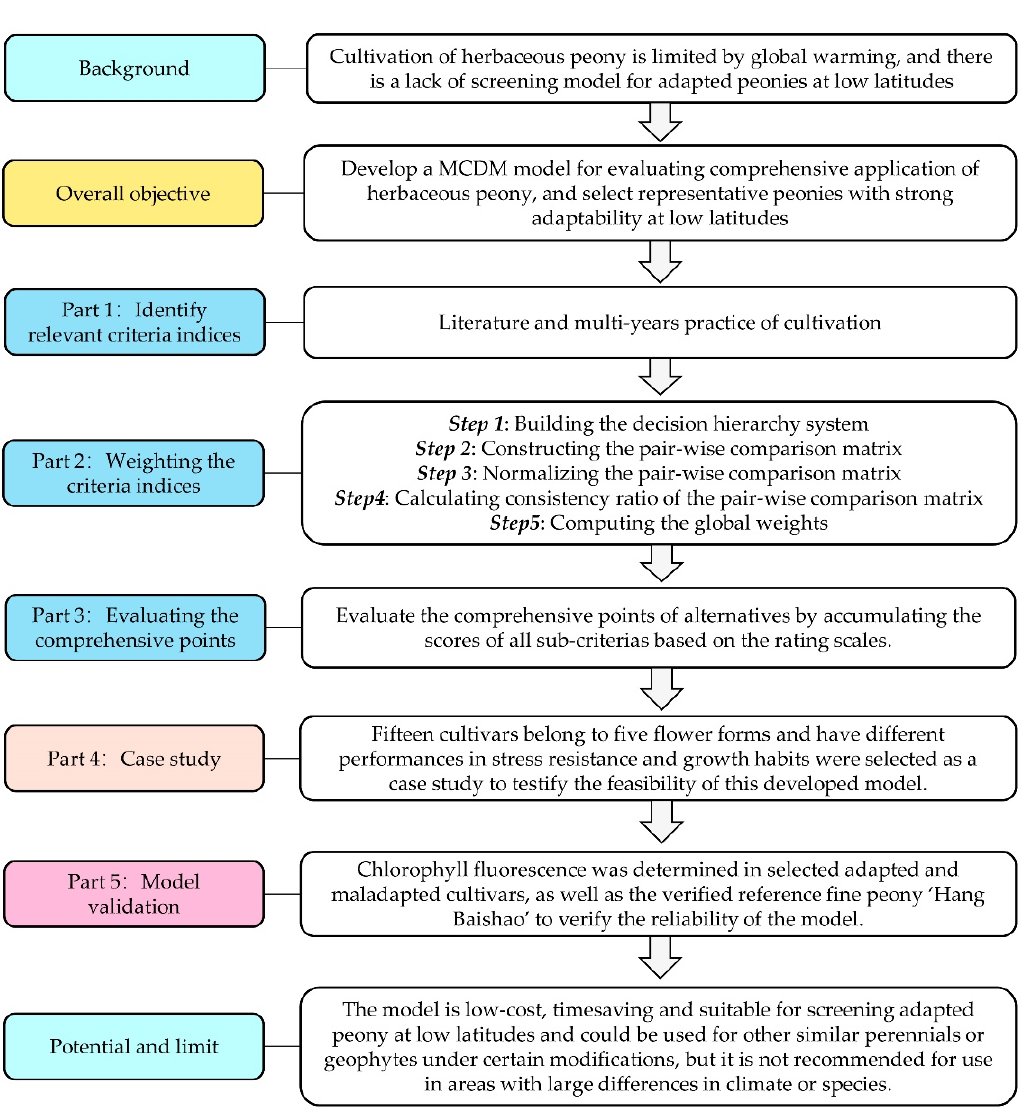
Figure 6. The process to create a multi-criterion integrated decision support framework for selecting elite herbaceous peony germplasm at low latitudes in this study.